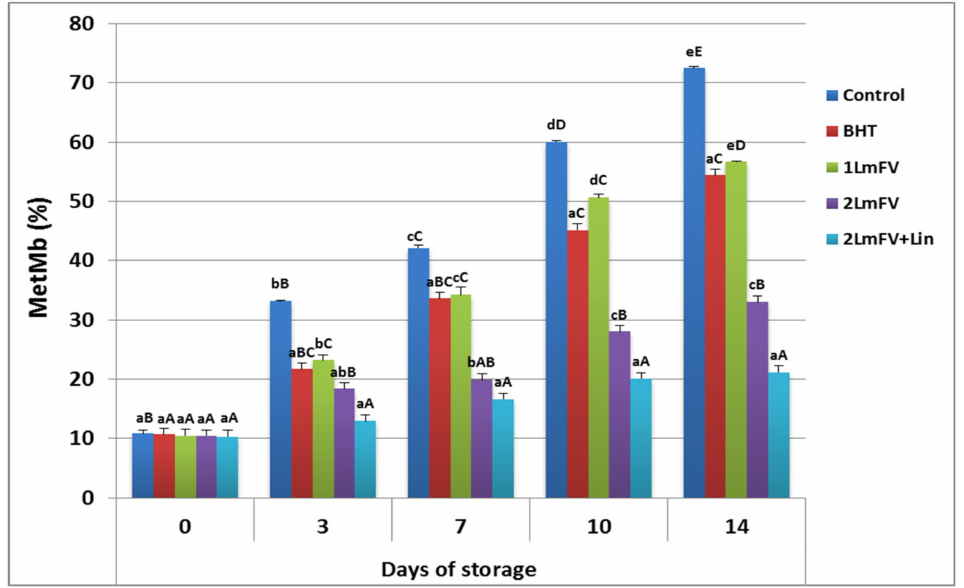
Figure 5. Effect of BHT, 1 Lm FV, 2 Lm FV, and 2 Lm FV+Lin on (a) MetMb (%) of raw minced beef stored at 4 ◦ C for 14 days; means ± SEMs (n = 3). Values with a different letter (a–e) for the same storage day are significantly different ( p < 0.05). Values with a different letter (A–E) for the same concentration are significantly